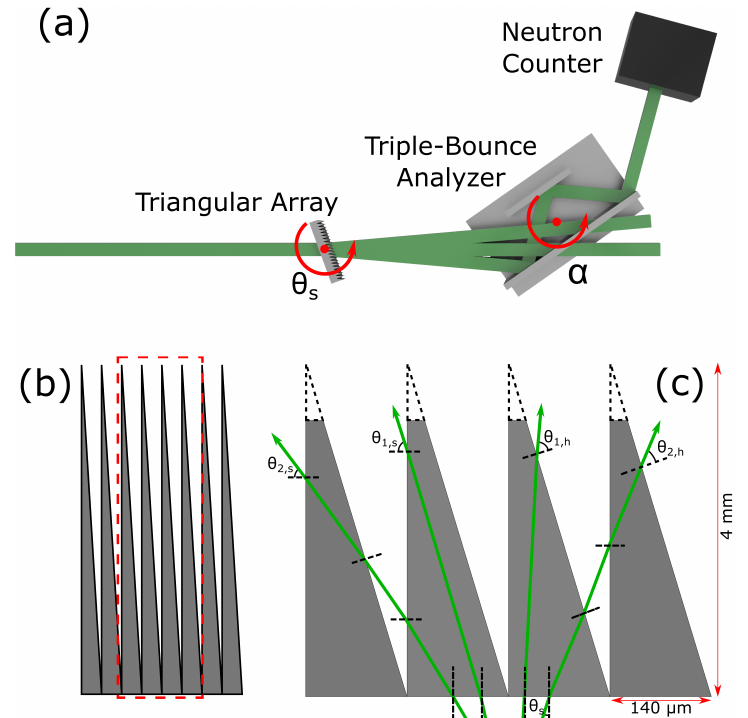
Figure 3. ( a ) Experimental apparatus used to measure beam deviation from the TARP. Small angle deviations are measured by utilizing a crystal applying Bragg diffraction to select a particular devia- tion angle caused by the sample. The neutron beam had a wavelength of 2.38Å ± 0.05Å, accounting for the reduction in wavelength at the sample due to Bragg refraction off the monochromator and the slit placed before the TARP device. The angles α and θ s correspond to the analyzer angle and sample angles, respectively. ( b ) Scaled schematic of TARP, where the red dashed box indicates the region which is magnified and shown with an exaggerated scale in ( c ). The aspect ratio shown here ( > 14) is correct for the prototype TARP. ( c ) Schematic of the TARP showing the arrangement and length scale of each prism. The neutron path and corresponding outgoing angle of the four possibilities modelled in Equations (1) to (4) are indicated as green lines. Imperfect prism apices are modelled as flat tops, shown here, with dashed lines indicating the ideal prism